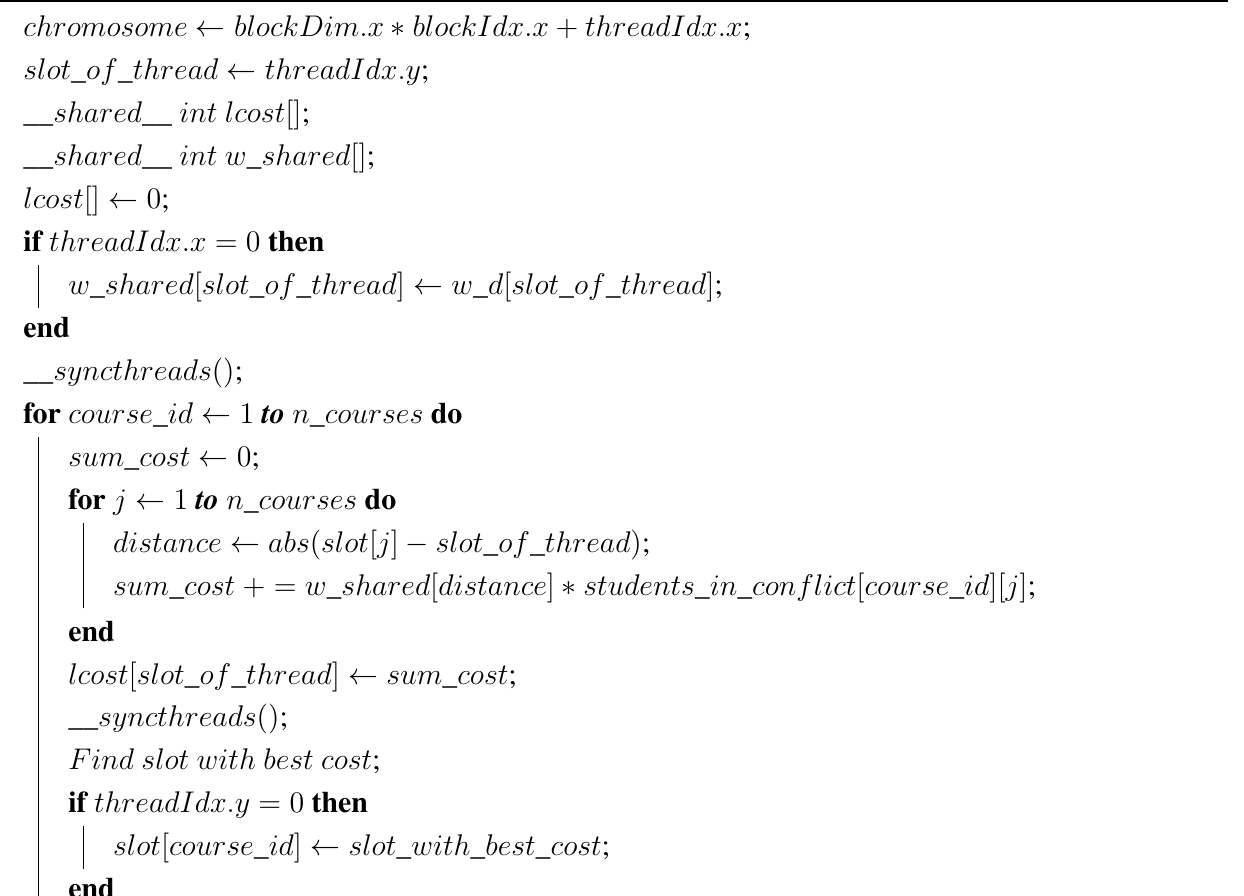
Algorithm 10: Greedy steepest descent algorithm: every thread calculates the cost of an examination for a specific time